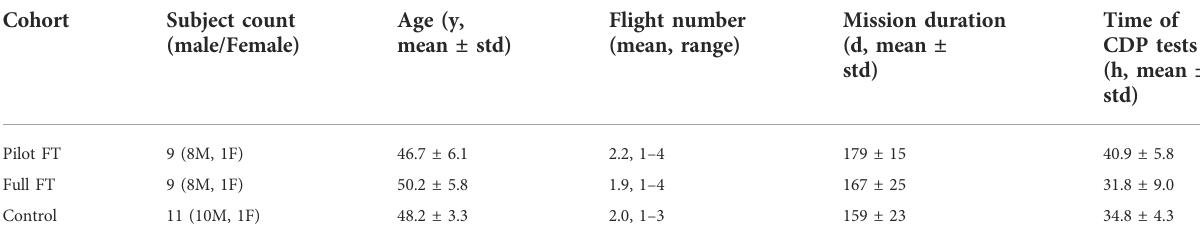
TABLE 1Demographics ofthe threecohorts, those whoparticipatedin PilotFieldTest, fullFieldTest, andControls. Notethat PFTand FullFT cohorts have been combined for fi nal analyses.